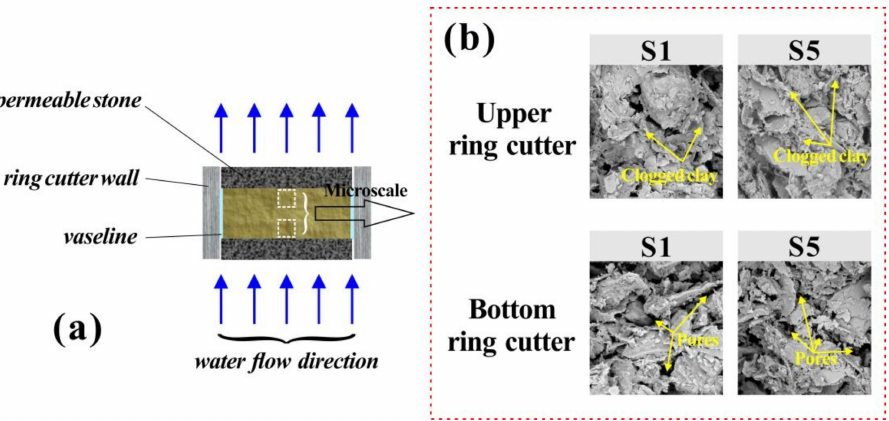
Figure 20. ( a ) Seepage direction of soil samples in ring cutter; ( b ) Microstructure characteristics of soil samples above and below the ring cutter after